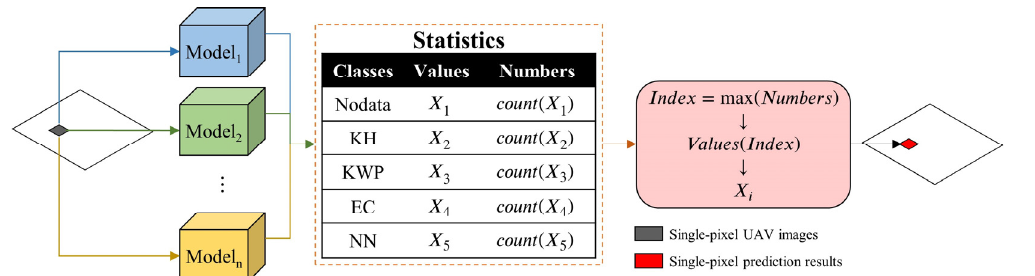
Figure 8. The framework of majority voting fusion method.